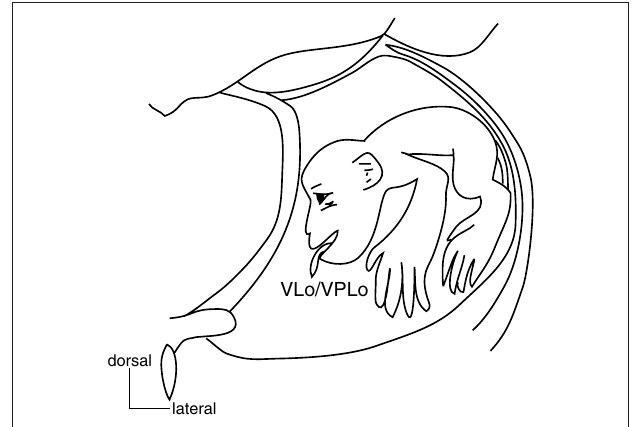
Figure 6 | Somatotopy of the thalamus. Somatotopy of the thalamus is shown in a frontal section. Both the oral part of the ventrolateral nucleus of the thalamus (VLo) receiving pallidal projections and the oral part of the ventroposterolateral nucleus of the thalamus (VPLo) receiving cerebellar projections have their own somatotopic representations. Their somatotopic representations are continuous rostrocaudally. Modified from Asanuma et